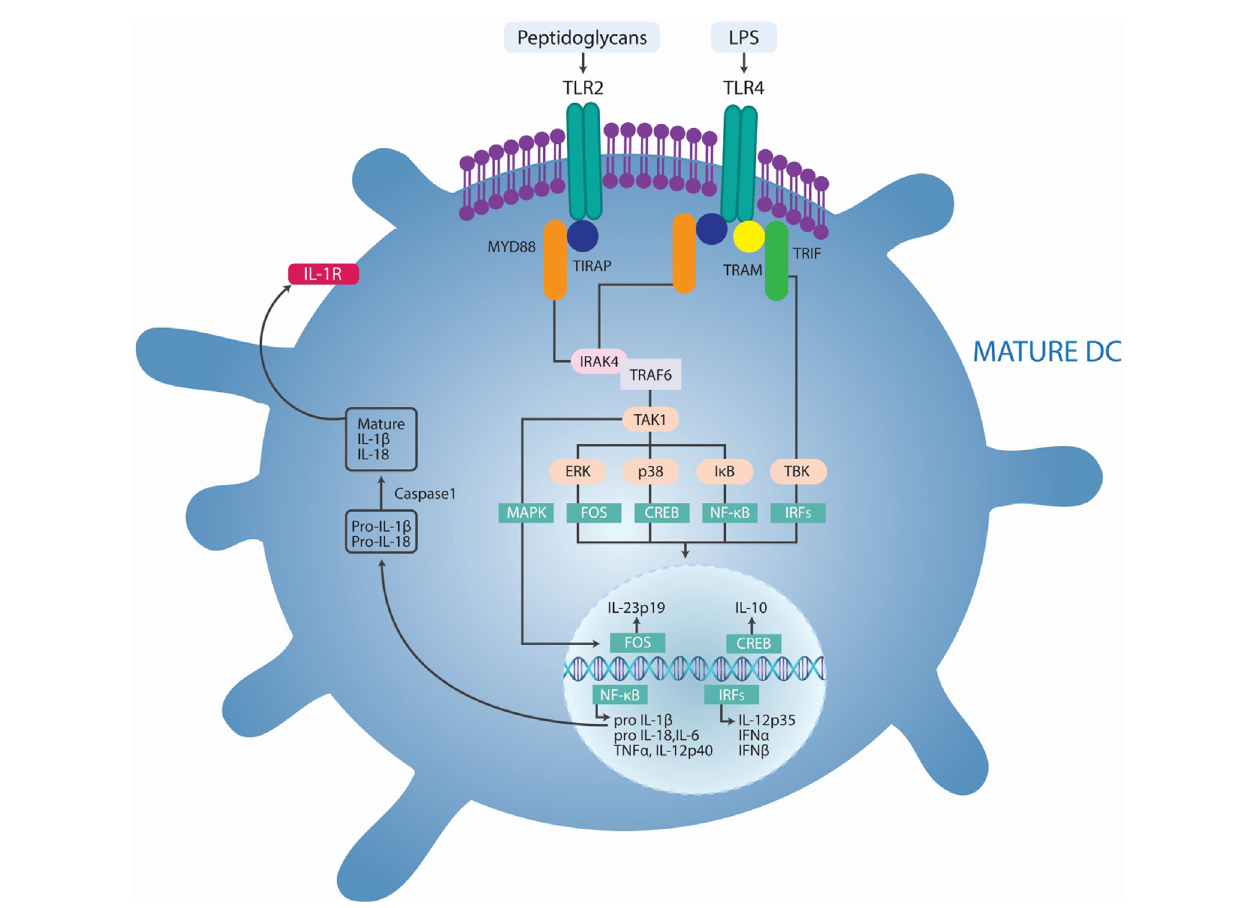
FiGURe 3 | Pathogens-induced TLR signaling cascade in innate immune cells may exacerbate autoimmune diseases . Lipopolysaccharide (LPS) binds to TLR4 and peptidoglycans bind to TLR2, which initiates signaling by recruiting the adaptor proteins myeloid differentiation primary response protein 88 (MYD88), the TIR domain-containing adaptor protein (TIRAP), TIR domain-containing adaptor protein inducing IFN- β (TRIF), and TRIF-related adaptor molecule (TRAM). MYD88 associates with IL-1R-associated kinase 1 (IRAK1) and IRAK4 and recruits TNFR-associated factor 6 (TRAF6). This complex recruits TGF β -activated kinase 1 (TAK1), leading to phosphorylation of NF- κ B inhibitor (I κ B), activation of nuclear factor- κ B (NF- κ B), and consequent transcription of a range of genes coding for proinflammatory cytokines, including tumor necrosis factor (TNF), interleukin-6 (IL-6), pro-IL-1 β , and pro-IL-18. In addition, TLR agonists activate the interferon regulatory factor (IRF) pathways, leading to the production of IL-12p35 and type I IFNs. TLR-induced activation of TAK1 also results in phosphorylation of mitogen-activated protein kinases (MAPKs), including p38 and extracellular signal-regulated kinase (ERK). Phosphorylation of ERK promotes the transcription of the gene encoding IL-23p19 and subsequent IL-23 synthesis. Phosphorylation of p38 activates cAMP response element-binding protein (CREB), leading to IL-10 production. IL-1 β activates its own receptor, which also signals via the same TLR pathway components to produce IL-1 β . Adapted from Ref.